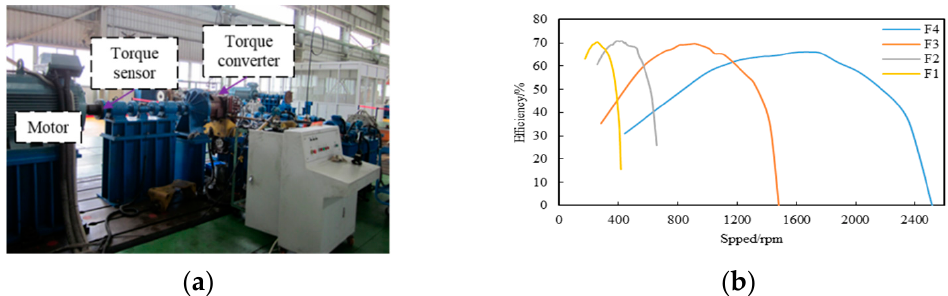
Figure 12. Torque converter efficiencies test. ( a ) The torque converter efficiencies test bench; ( b ) the torque converter’s efficiencies under different gear positions.